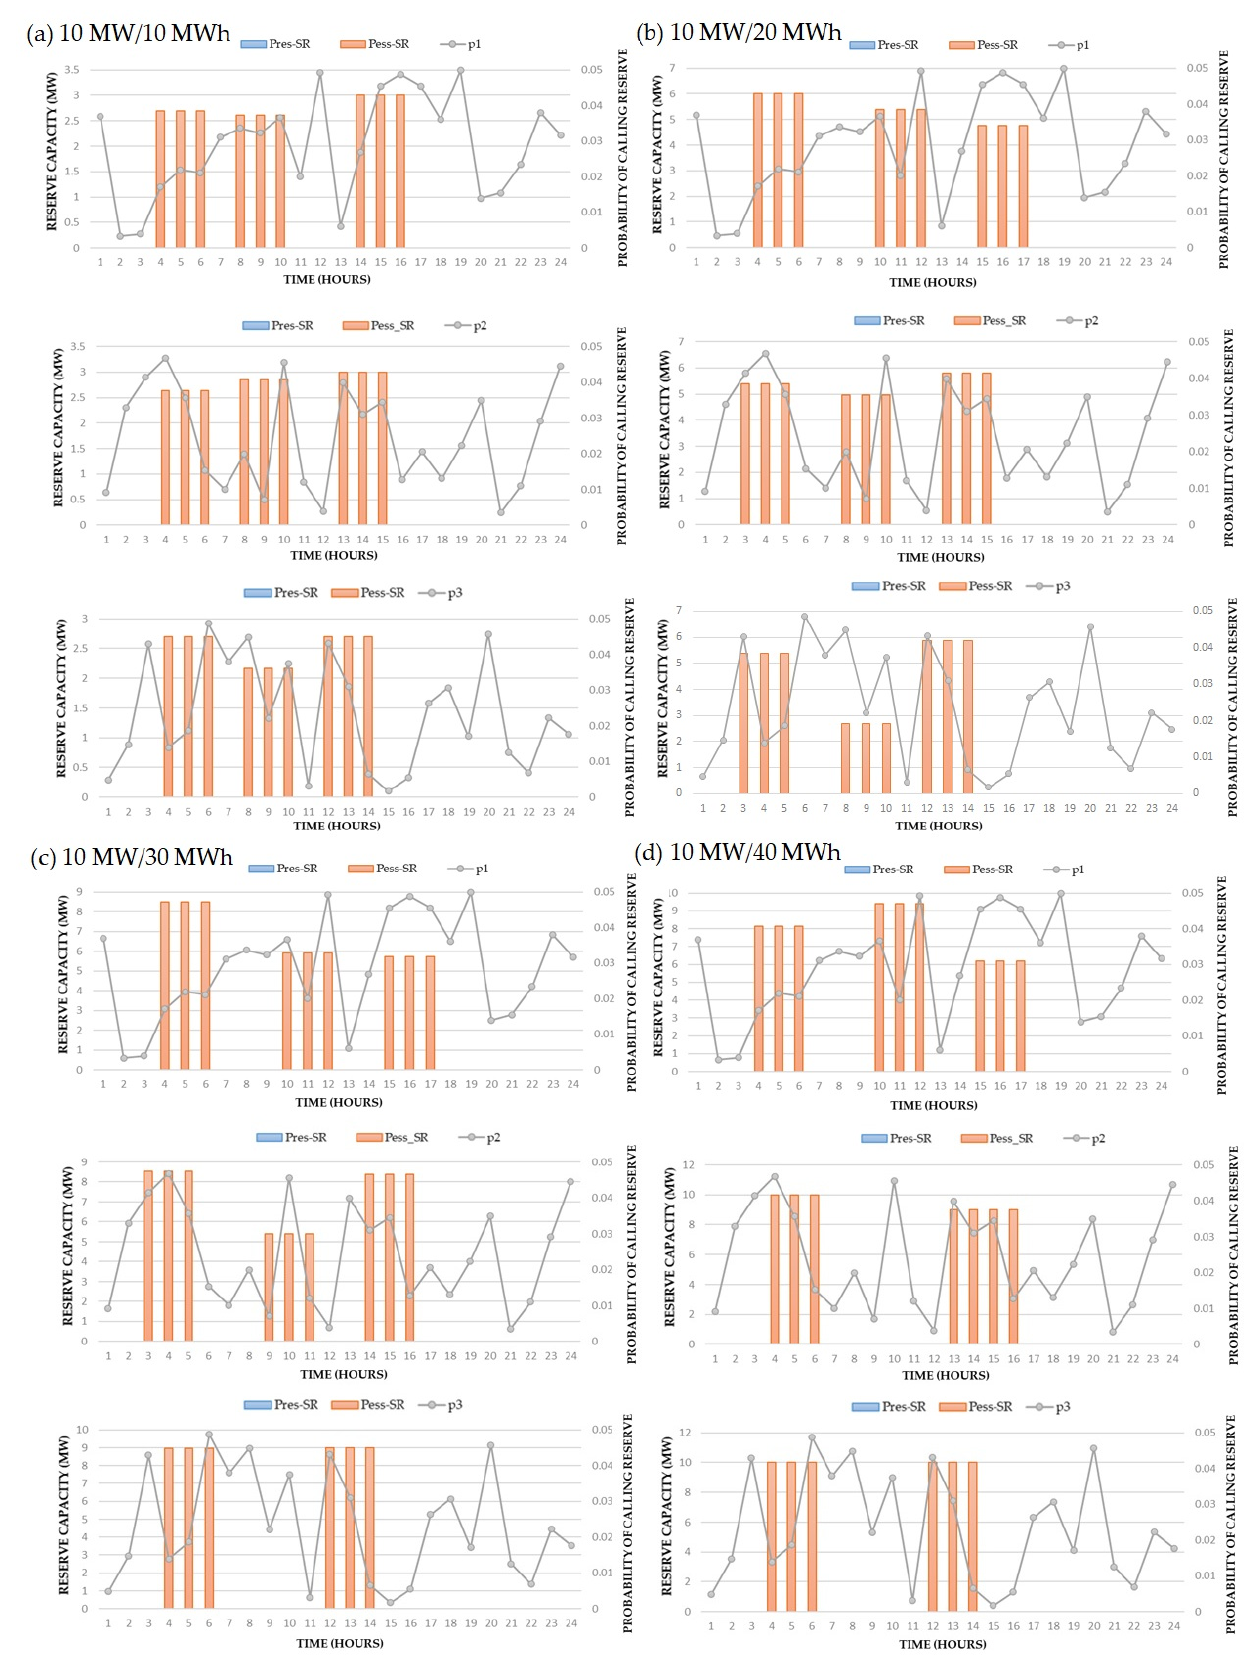
Figure 15. The VPP’s reserve bidding with different ESS capacity and reserve probability scenarios.